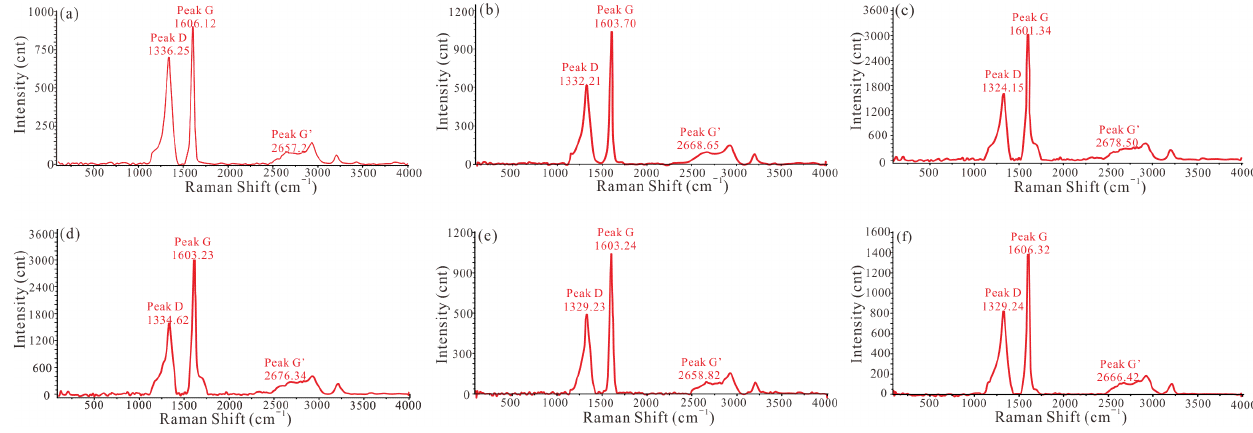
Figure 6. Raman spectrum of representative shale samples from the Changing block and the